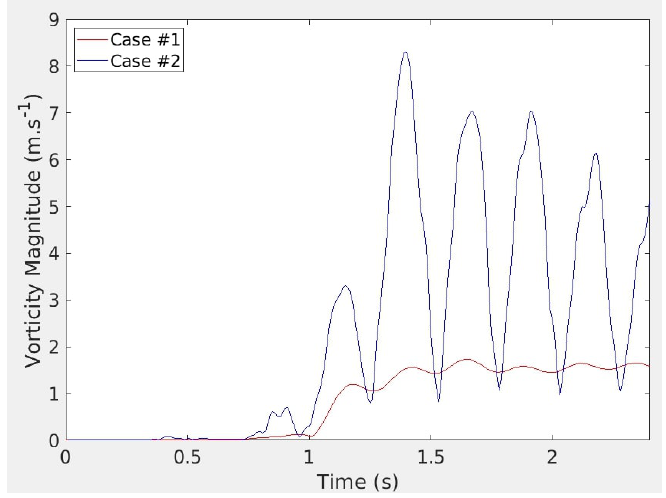
Figure 15. Time evolution of the vorticity magnitude close to the rotor, inside the AMI zone ( x ∗ = 2), for coarse (#1 with red line) and refined (#2 with blue line) meshes.